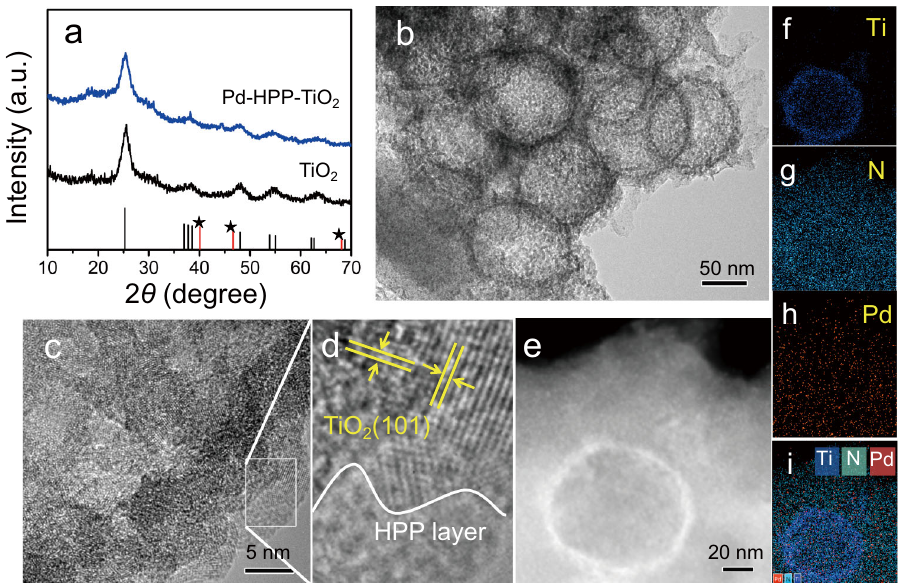
Fig. 4 Crystal and morphology characterizations. a XRD patterns of TiO 2 and Pd-HPP-TiO 2 . The vertical lines are the position and intensity of anatase TiO 2 (JCPDS 21-1272) and Pd (labeled by the star, JCPDS 46-1043). b TEM, c , d HRTEM, e STEM, and f – i the corresponding EDX element mapping images of Pd-HPP-TiO 2 tests. Figure 4e – i display that hollow TiO 2 is embedded in Pd- HPP with a homogeneous distribution of C, N, and Pd elements.